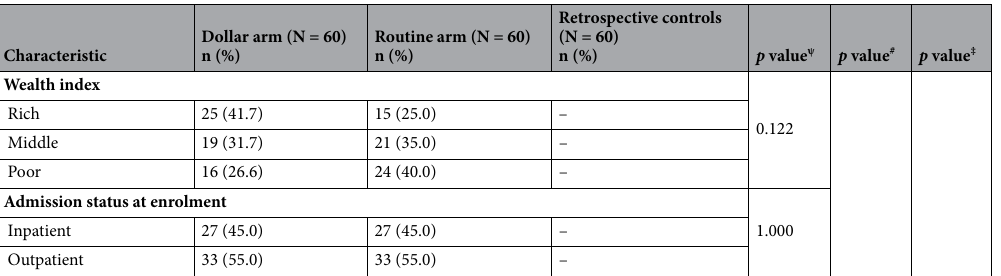
Table 2. Comparison of baseline characteristics of participants in the study groups. † For 6 participants in the Dollar arm, the HIV status was unknown. § Percentages are for participants with history of TB treatment who had data available. ART—antiretroviral therapy, TB—tuberculosis, “–” denotes missing variable. 1 Fisher’s exact test, *n = 27 for Routine arm, n = 20 for Dollar arm and n = 30 for Retrospective controls. ψ p value compares Dollar arm and Routine arm. # p value compares Dollar arm with Retrospective controls. ‡ p value compares Routine arm with Retrospective controls.